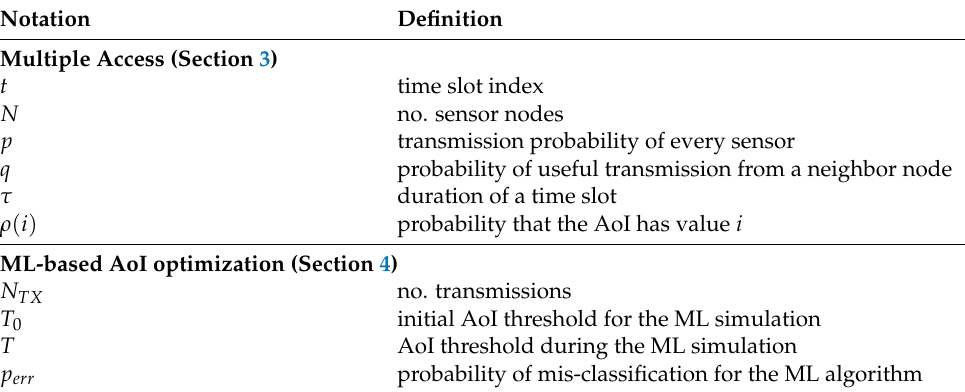
Table 2. List of symbols used in the article (in order of appearance in the following).